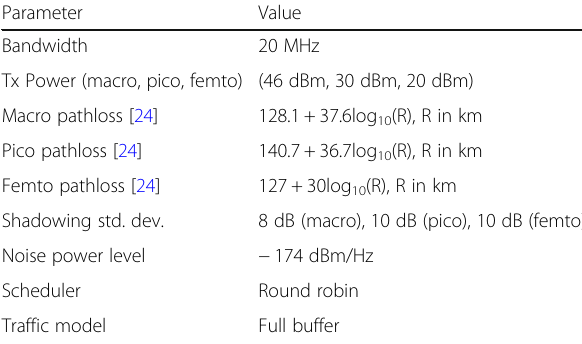
Table 1 Simulation